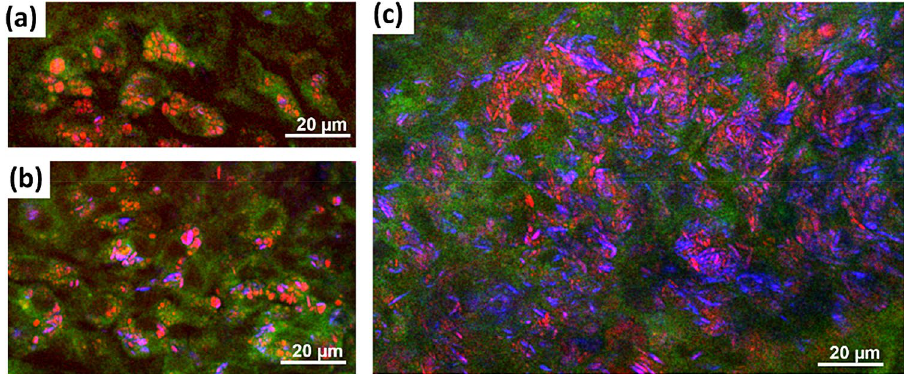
Figure 7. Multimodal images of acoronary leaflet regions of ApoE −/− mice showing the morphology of lipid accumulations. Red channel: CARS; green channel: TPEF; blue channel: SHG. ( a ) Intracellular lipid droplets. ( b ) Intracellular lipid droplets and cholesterol crystals. ( c ) A massive accumulation of lipid and cholesterol crystals without clear intracellular localization. In all images, the green TPEF visualizes cytoplasm and the nucleus, which is devoid of fluorophores, appears as dark